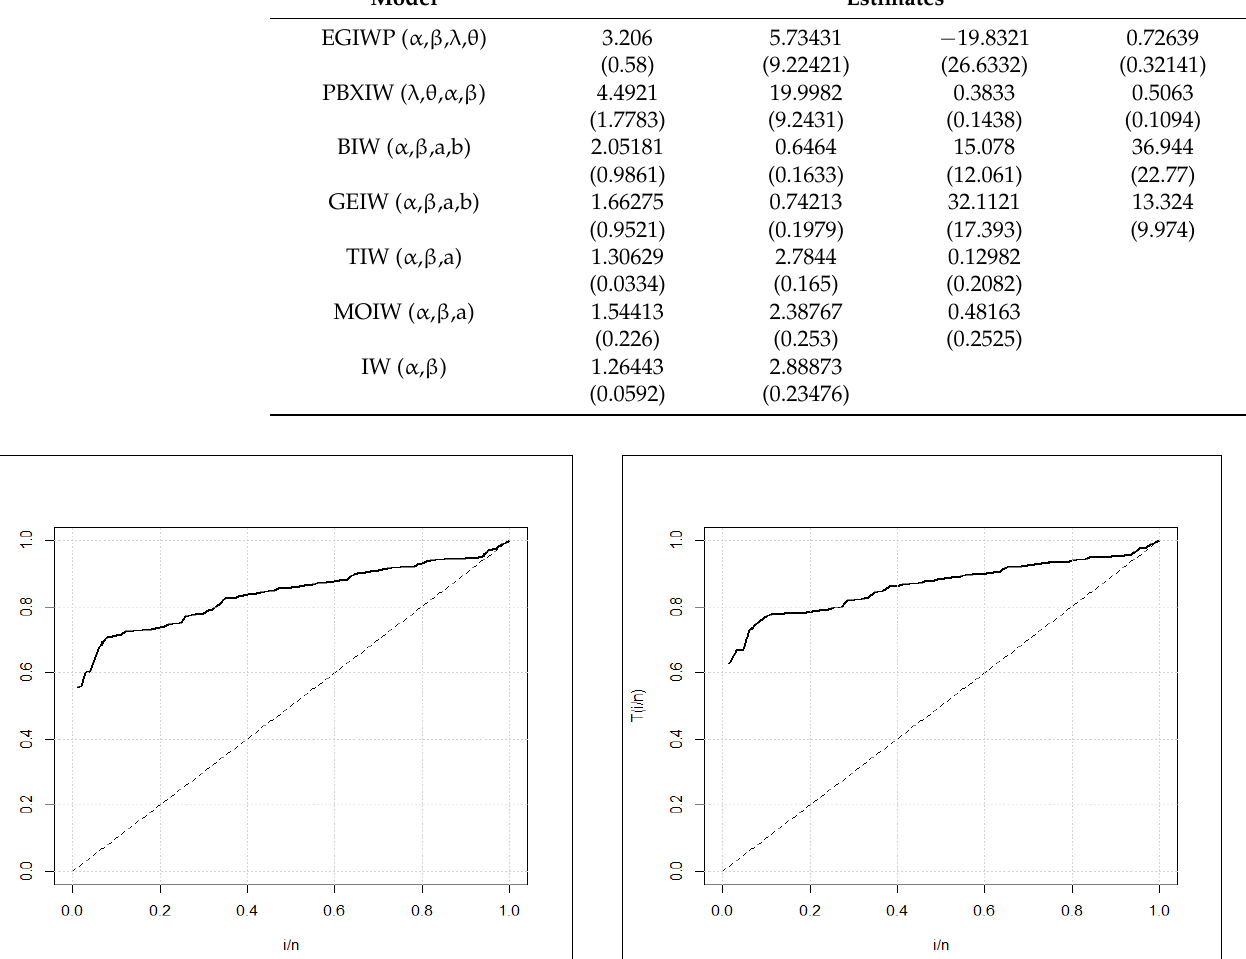
Figure 3. TTT plot for breaking stress of carbon fibers ( left ) and TTT plot for the strengths data of the glass fibers ( right ).